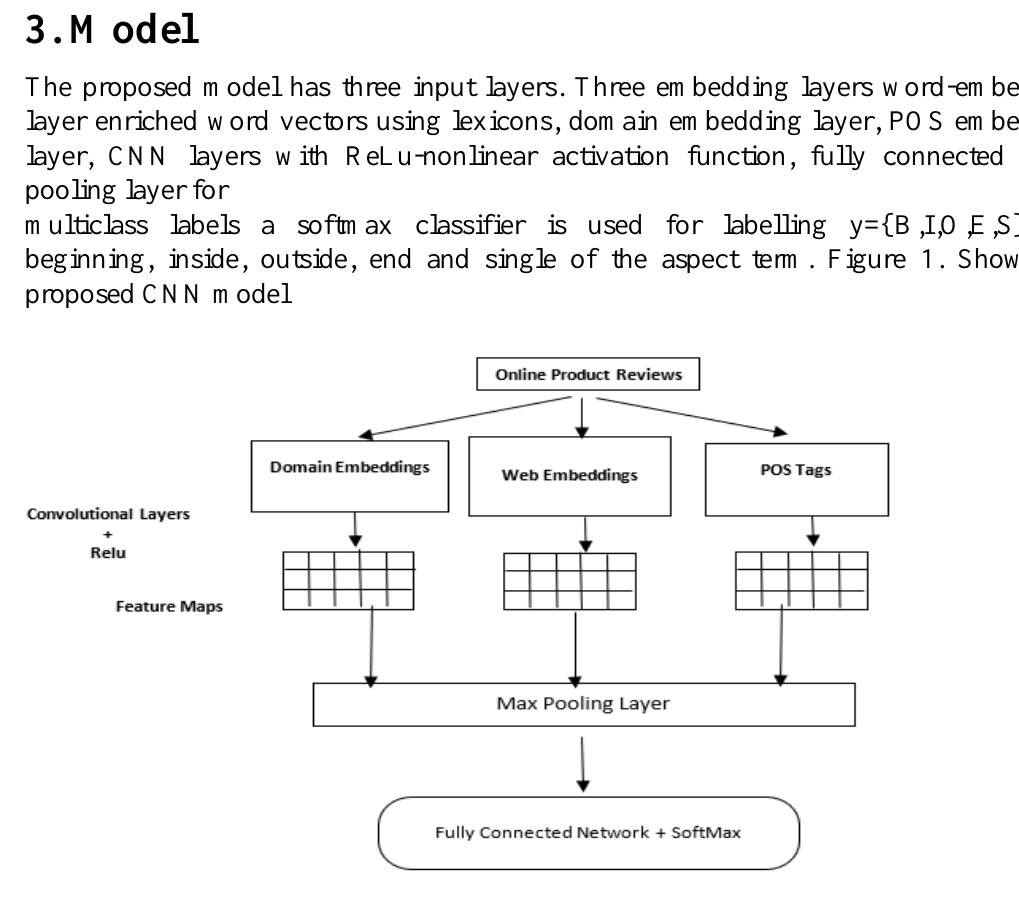
Figure 1. Proposed Convolution Neural Network